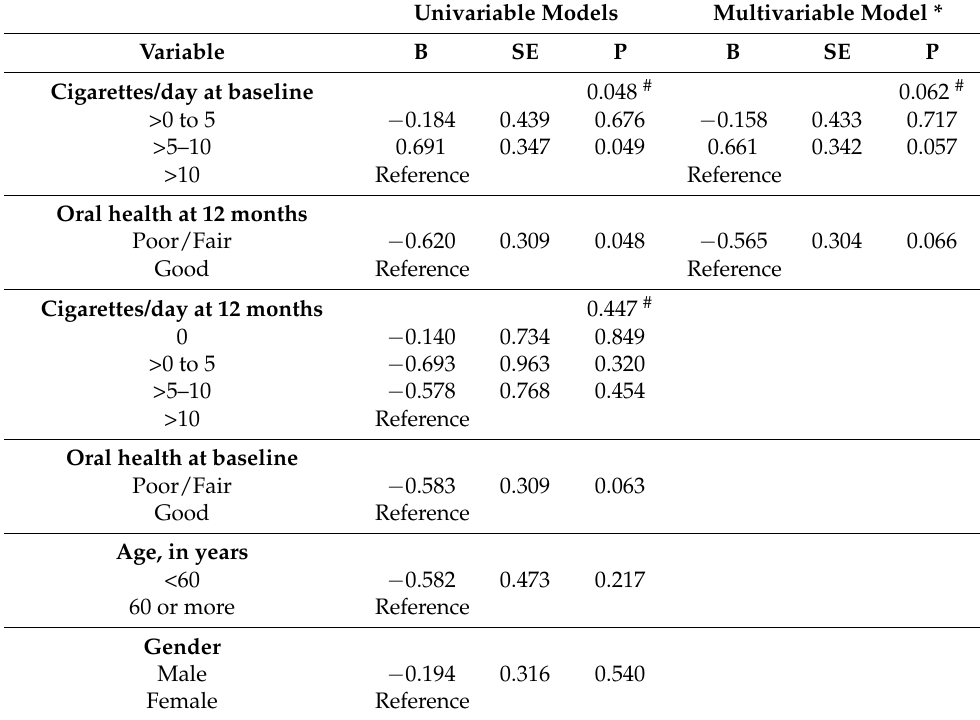
Table 4. Estimates regression coefficient (b) and corresponding standard error (se(b)) and p values (P) for univariable and multivariable models for outcome CD44 change at 12 months from